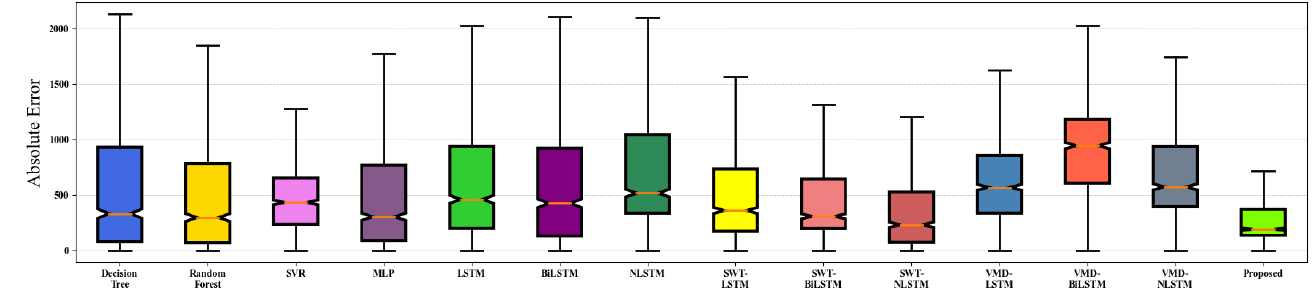
Table 8. Training time in seconds for different forecasting models.